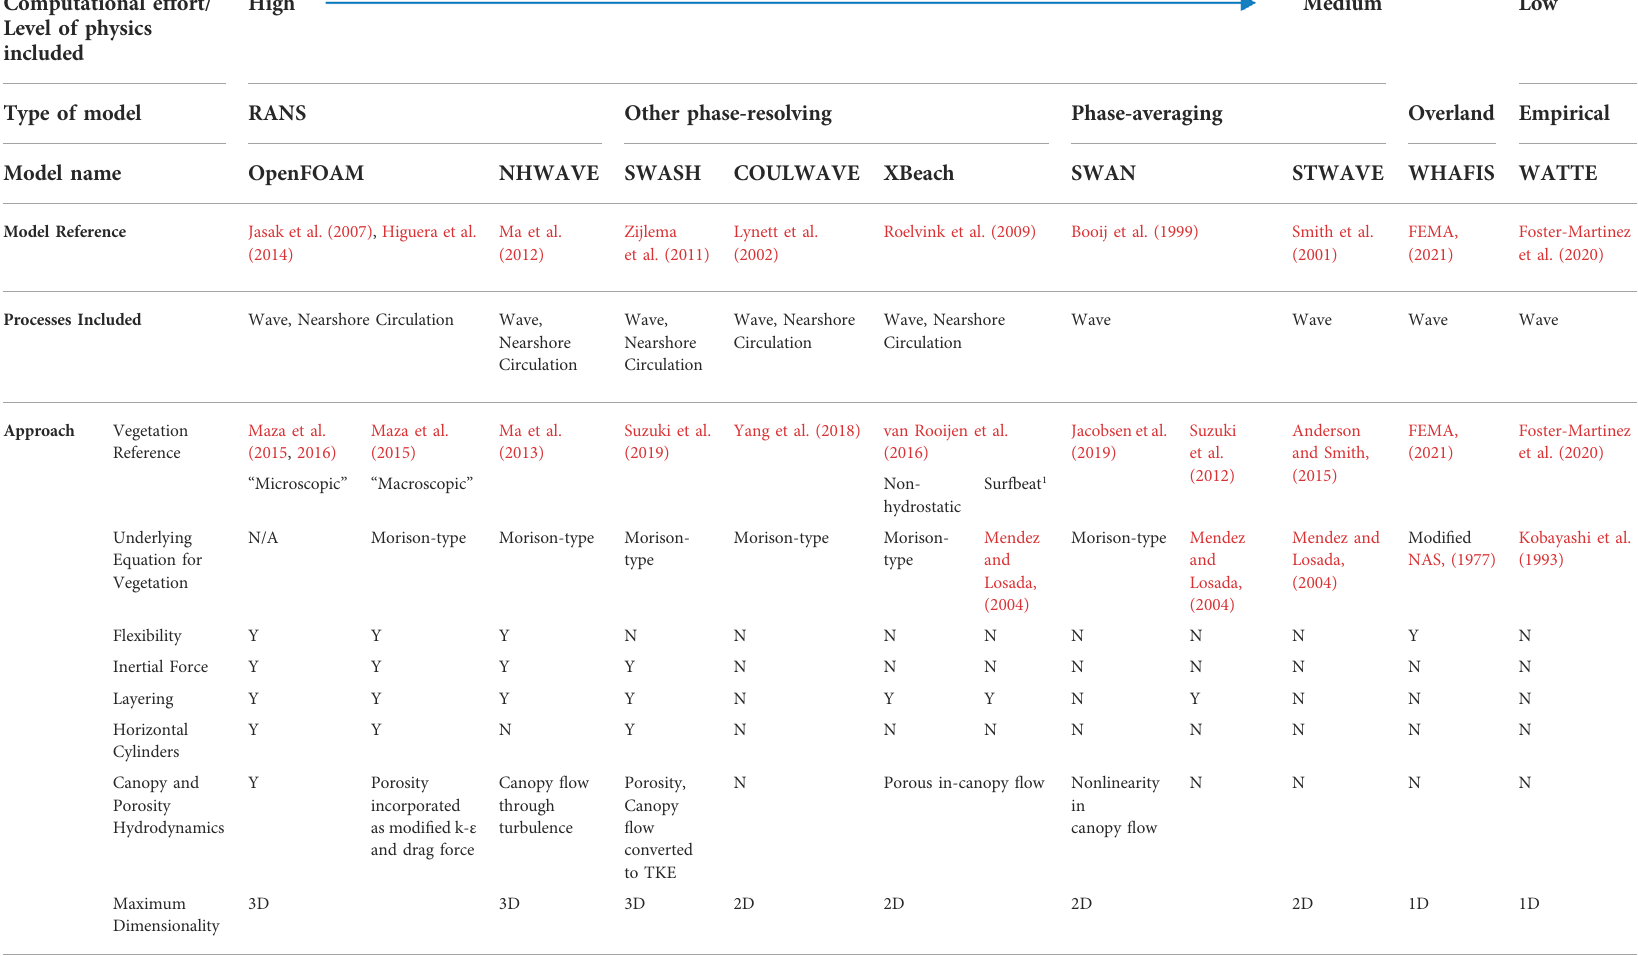
TABLE 2 Commonly used computational and analytical models for determining wave height attenuation through emergent